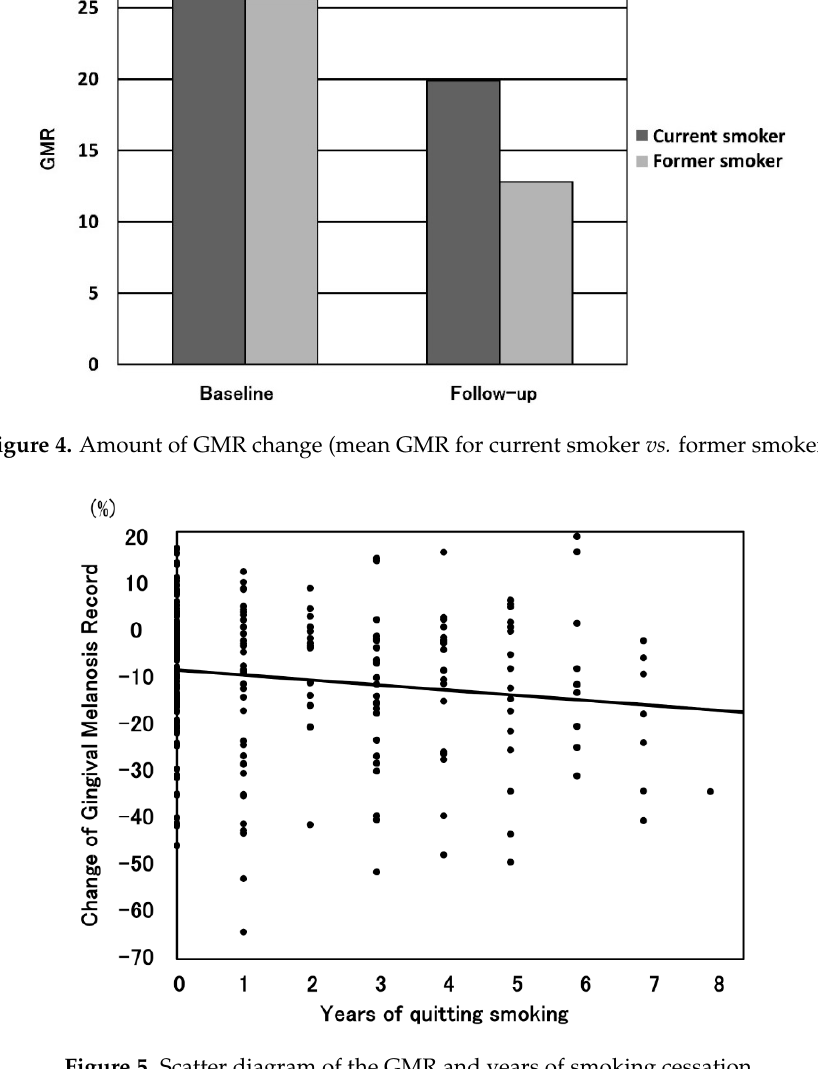
Figure 5. Scatter diagram of the GMR and years of smoking cessation.